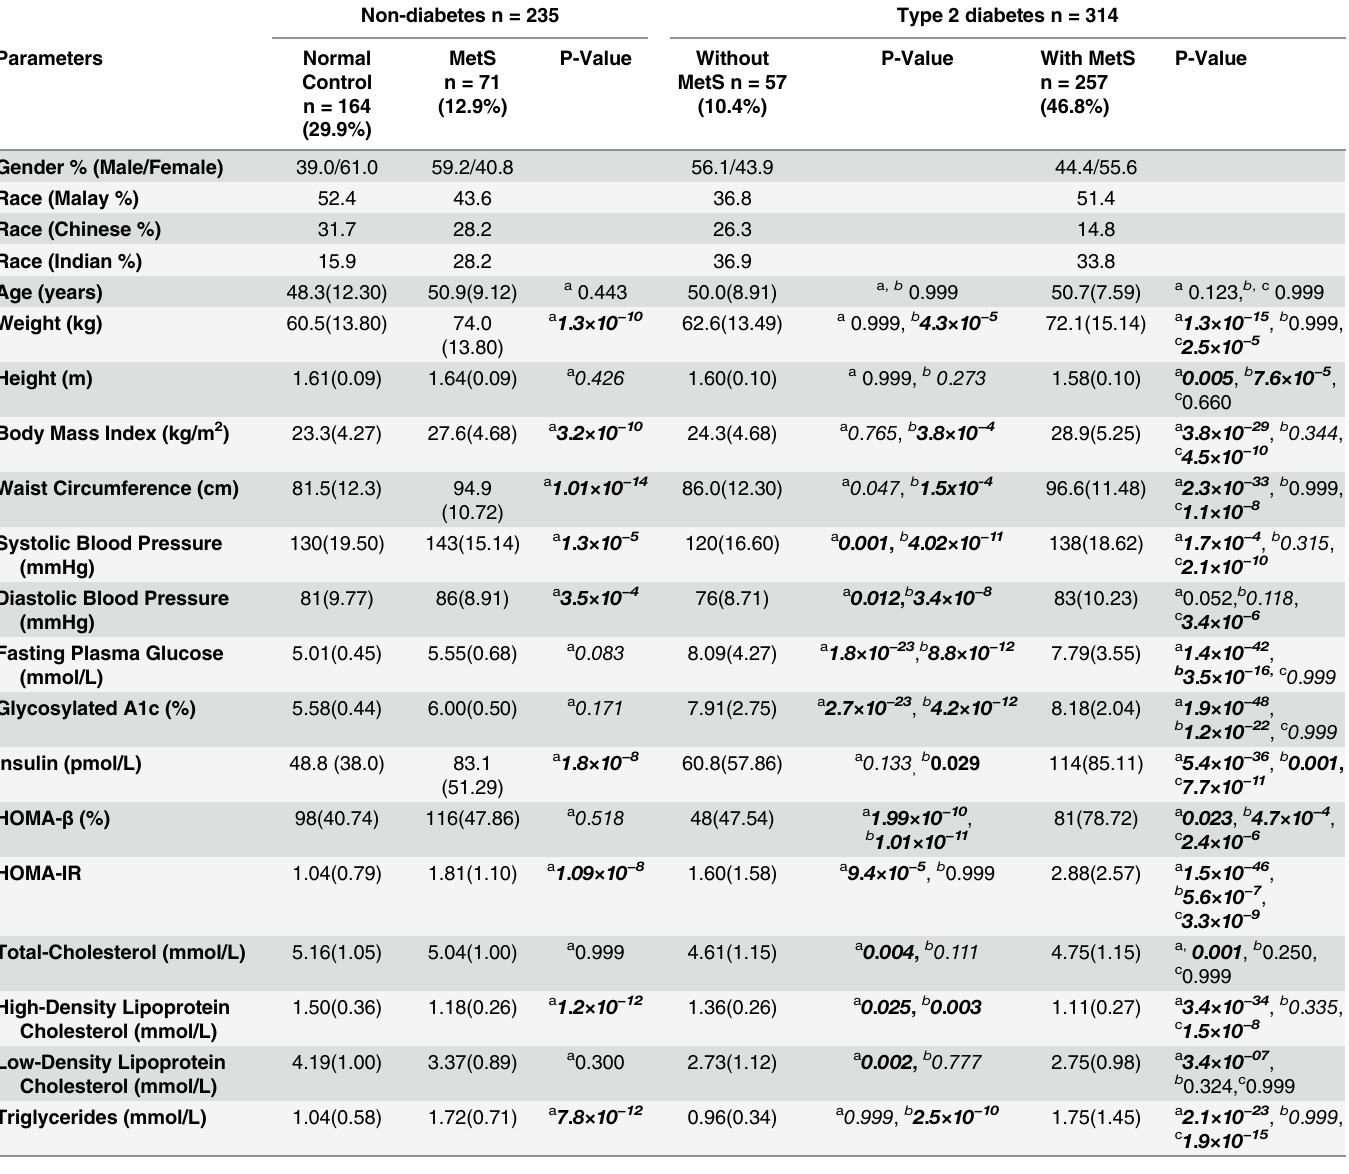
The results presented represent geometric means (SD) a vs normal control group b vs non-diabetes MetS group c vs type 2 diabetes mellitus without metabolic syndrome evaluated using